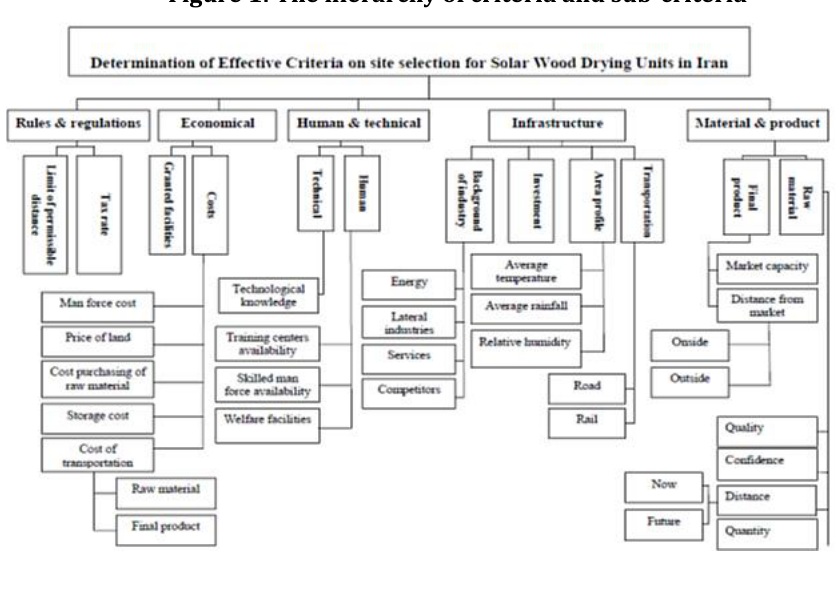
Figure 1: The hierarchy of criteria and sub-criteria